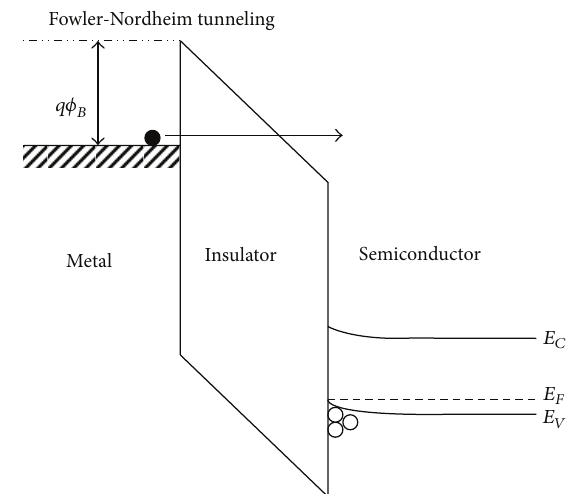
Figure 5: Schematic energy band diagram of Fowler-Nordheim tunneling in metal-insulator-semiconductor